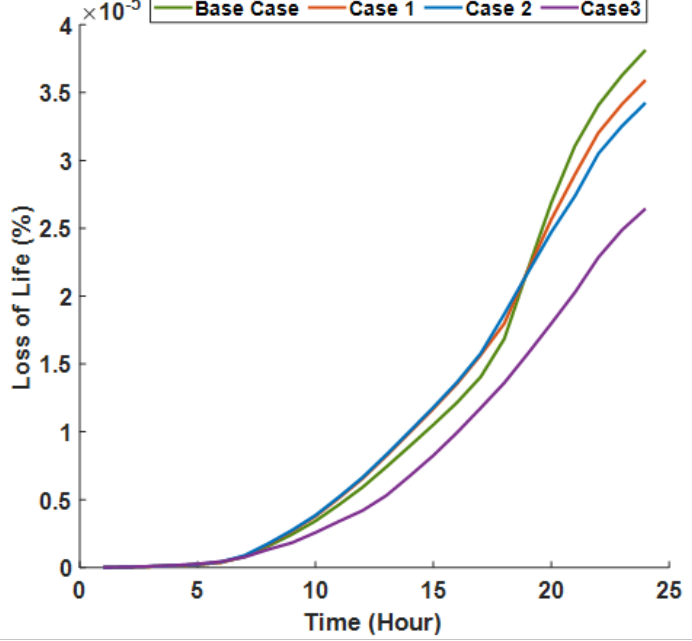
Figure 11. The impact of the DR on distribution transformer loss of life (LoL) %.